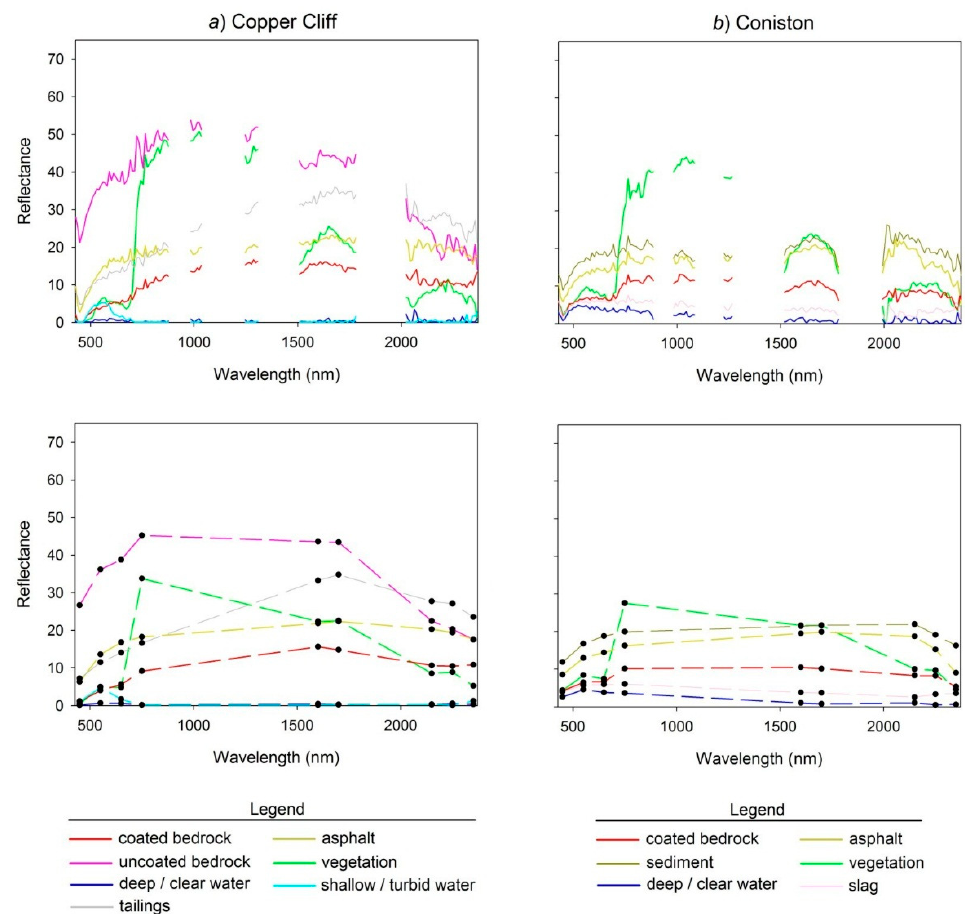
Figure 8. Hyperion-derived reflectance spectra, expressed as percentages, for endmembers of interest in the Copper Cliff ( a ) and Coniston ( b ) study areas, over wavelengths of 400 to 2400 nm. Original spectra are given at top and multispectral versions are given at bottom.